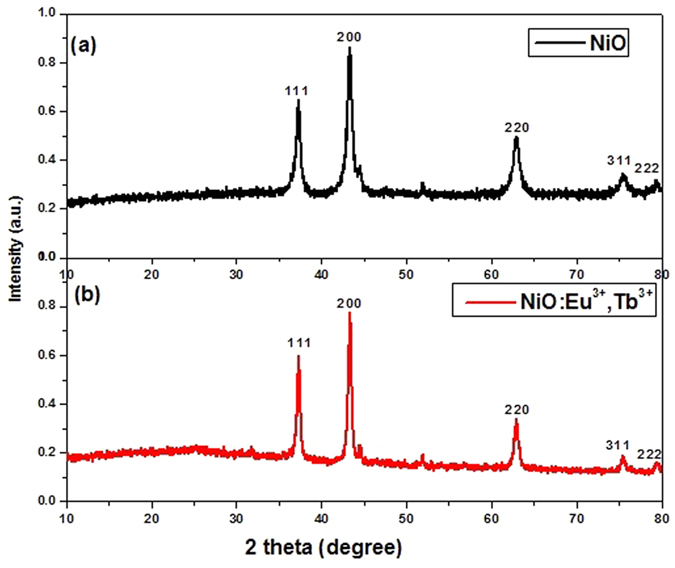
XRD patterns of (a) NiO and (b) NiO:Eu3+,Tb3+.